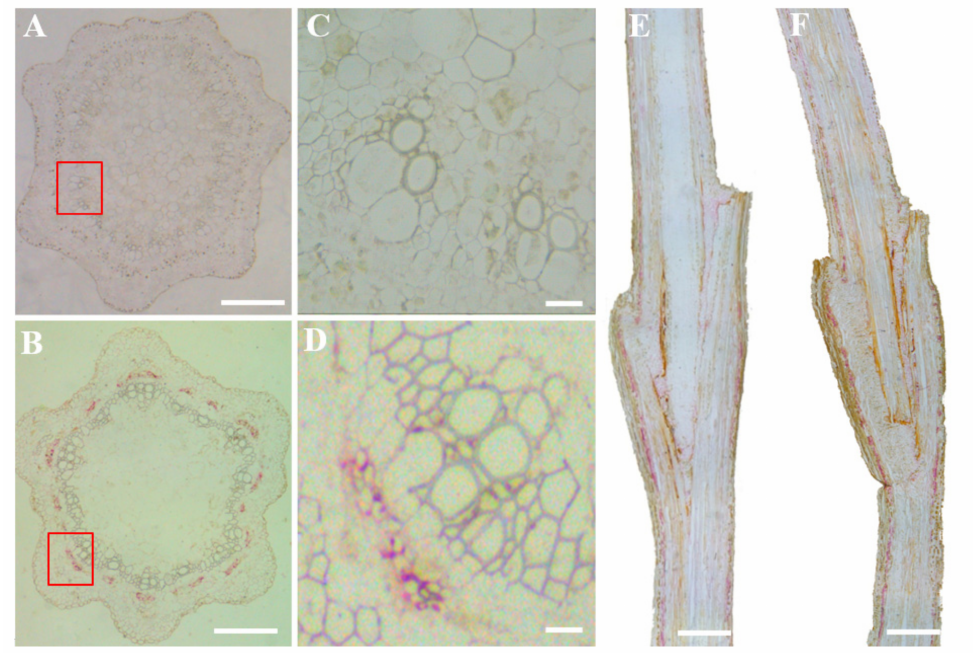
Figure 5. Histological observation and virus location in micrograft. ( A , C ), Negative control; ( B , D ), Positive control; the plantlets of GLRaV-3 infected ‘Cabernet Sauvignon’ grafted on healthy ‘Chardonnay’ Bar = 0.5 mm ( A , B , E , F ), 5 µ m ( C , D ).